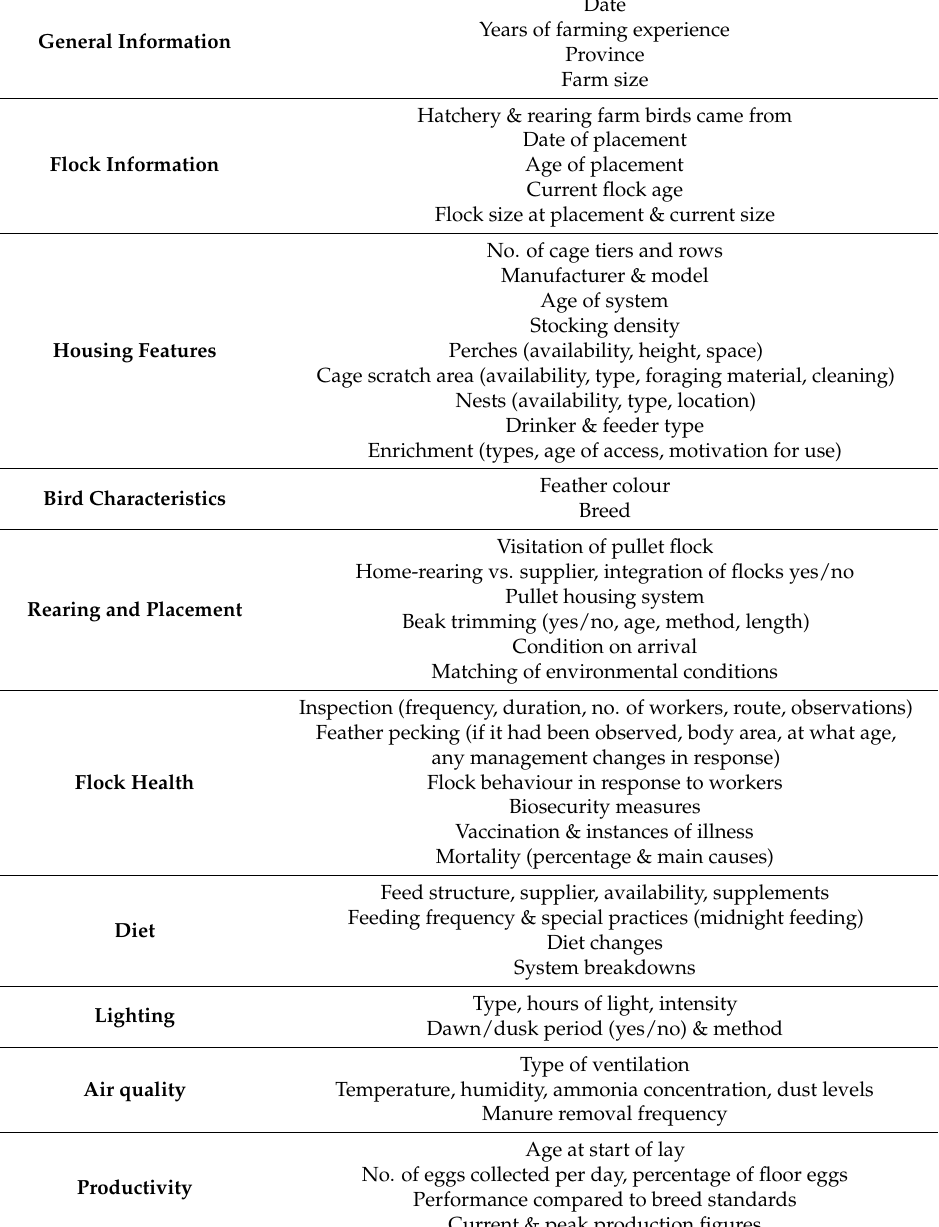
Table 2. A summary of the housing and management information about a farmer’s current laying hen flock collected through the self-administered